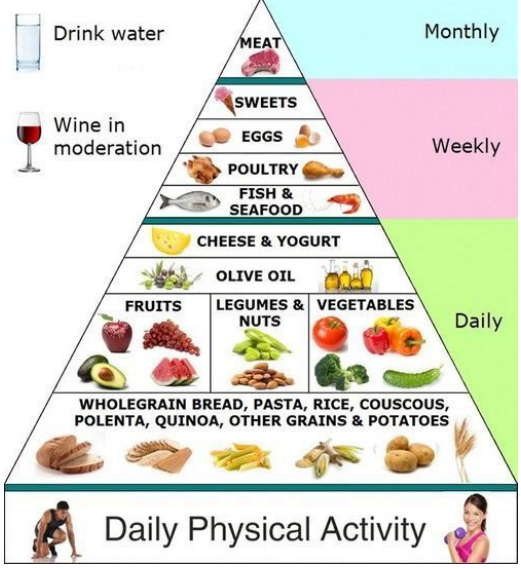
Figure 11. The Mediterranean diet pyramid.